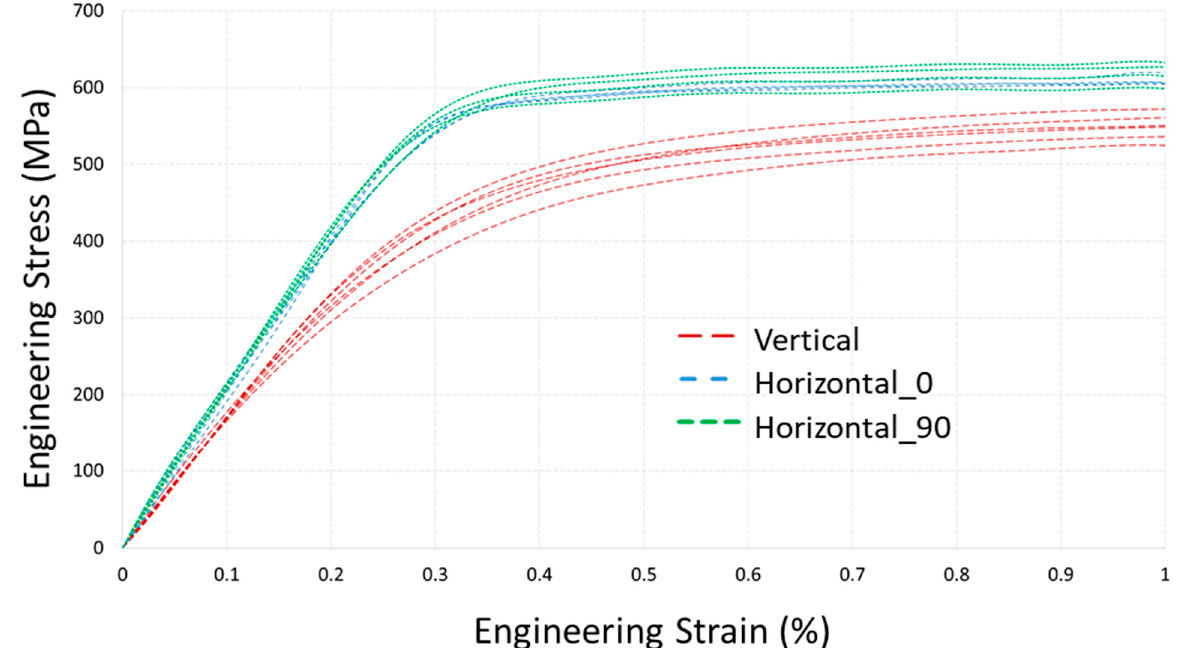
Figure 3. Tensile test results of LPBF processed as-build 316L samples.